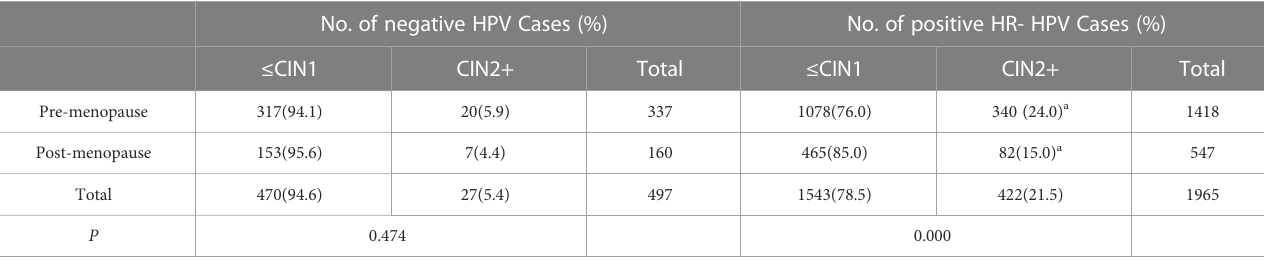
a P < 0.05 compared with the HPV-positive counterpart